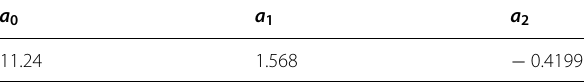
Table 1 Resultant coefficients of the risk curve for the general population fitted to Eq.